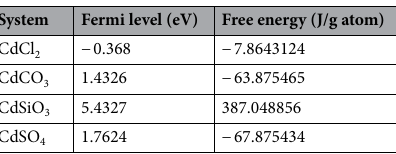
Table 2. Energy parameters of CdCl 2 , CdCO 3 , CdSiO 3 and CdSO 4